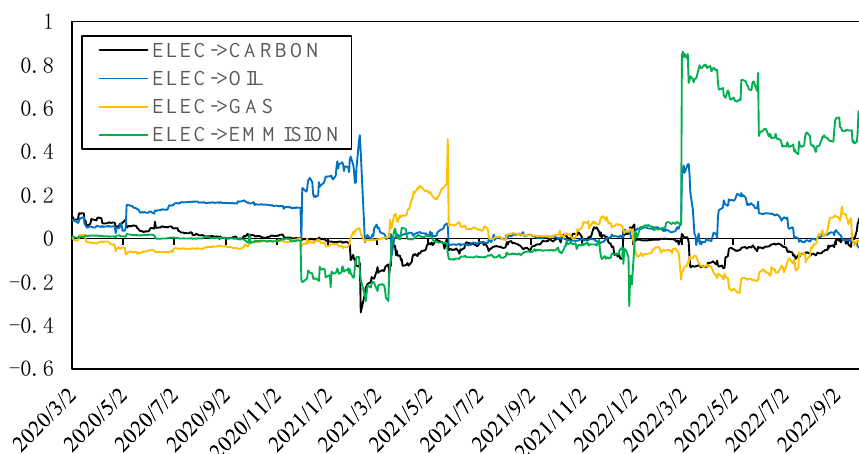
Figure 9. Dynamic spillover effects of electricity return.